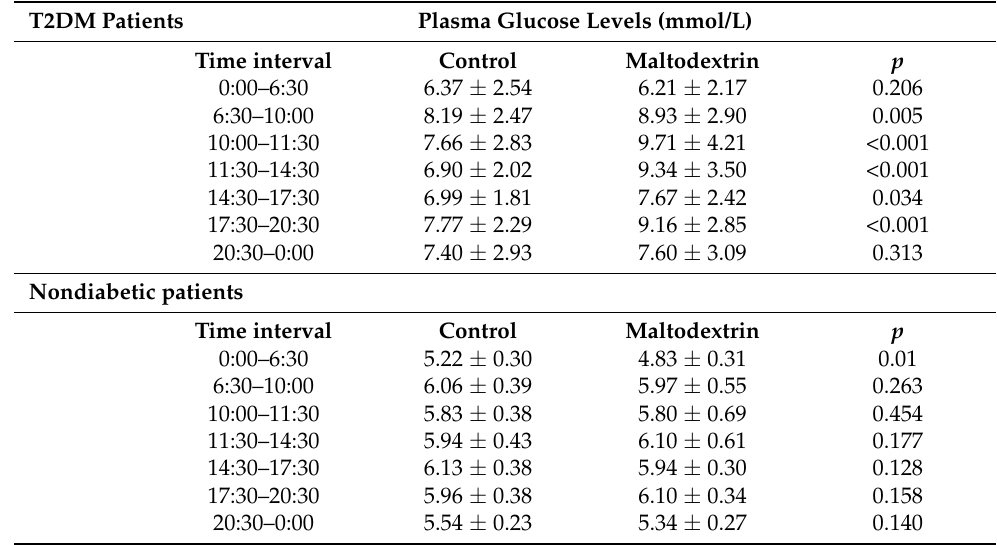
Table 2. Effects of maltodextrin addition on mean glycaemia in diabetic and nondiabetic patients. T2DM